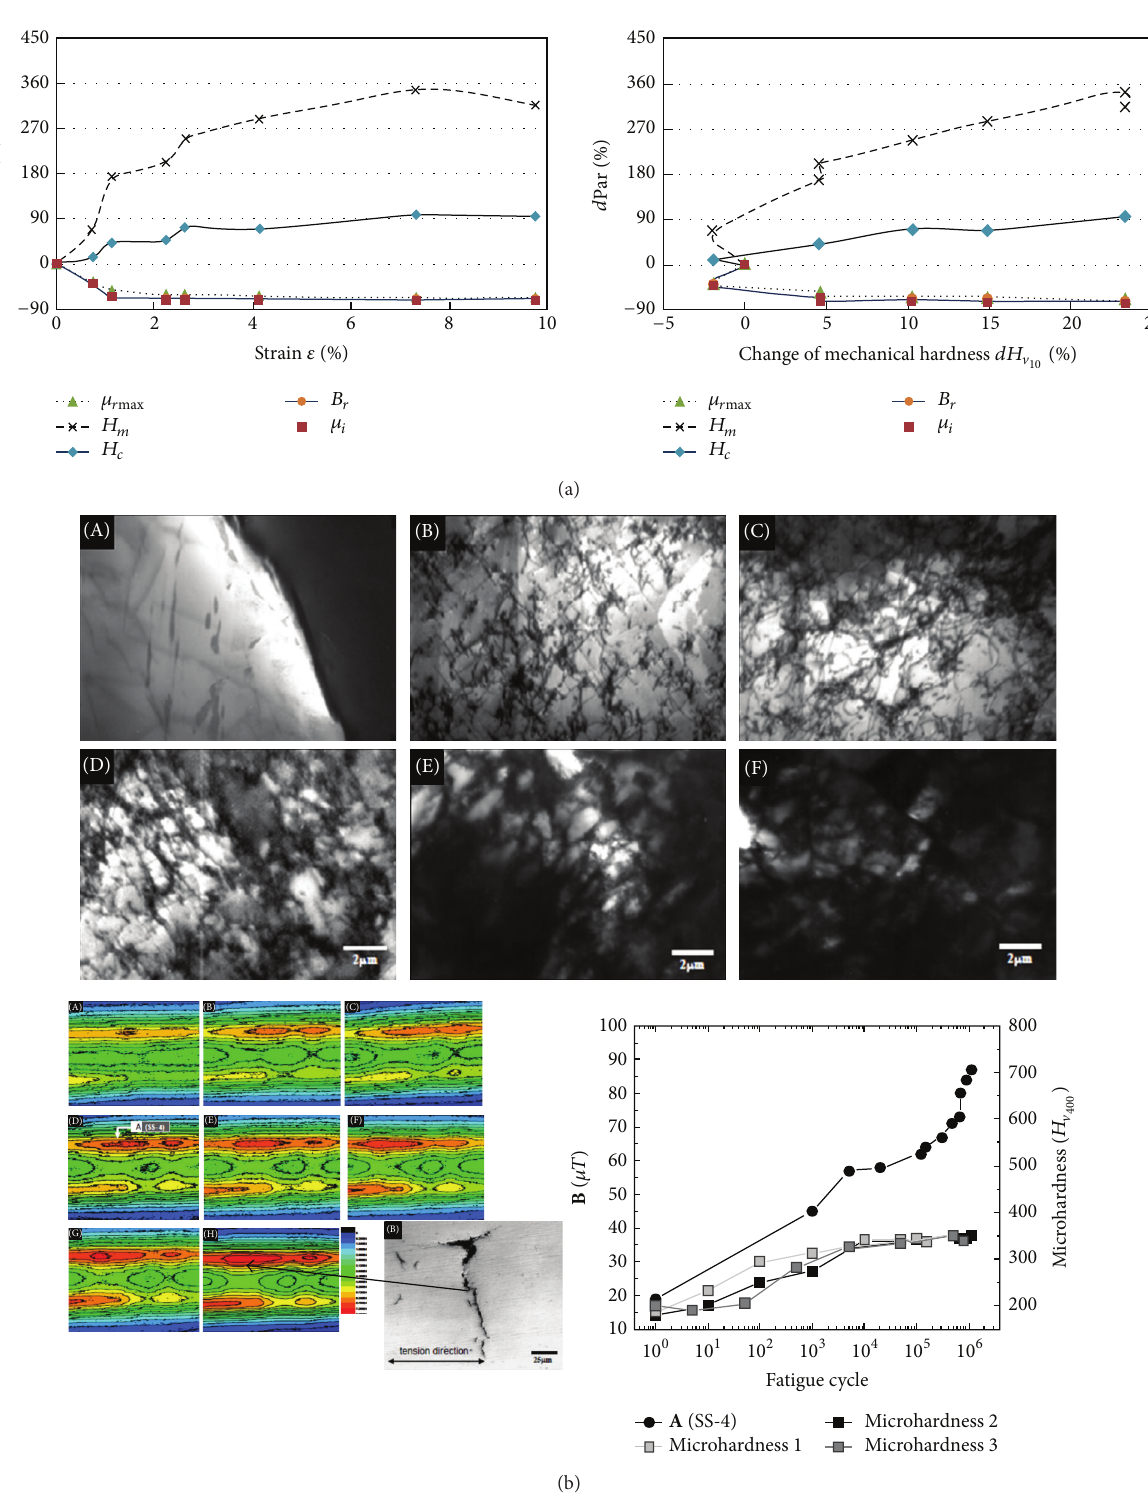
Figure 12: Showing (a) influence of static strain hardening on magnetic parameters low carbon steel with 0,17% C (𝐻 𝑚 = 𝐻(𝜇 𝑟 max )), 𝑑 Par = ( Par (𝜀) − Par (𝜀 = 0)/ Par (𝜀 = 0)) [73]; (b) influence of HCF on TEM microstructure of fatigue 430 stainless steel (after 0 cycles, 1 × 10 3 cycles, 1 × 10 4 cycles, 2 × 10 4 cycles, 4 × 10 5 cycles, 5 × 10 5 cycles) and remanence magnetization map of the steel (after: (A) 0 cycles, (B) 1 × 10 3 cycles; (C) 5×10 3 cycles; (D) 2×10 4 cycles; (E) 1,2 ×10 5 cycles; (F) 1,45 ×10 5 cycles; (G) 2,8 ×10 5 cycles; (H) 9,2 ×10 4 cycles. SQUID scanning area 10 × 20 mm)